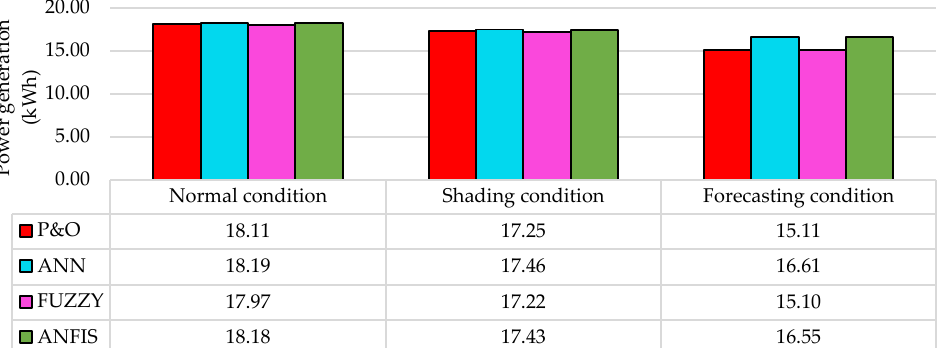
Figure 13. Power generation of the PV system for control algorithms.